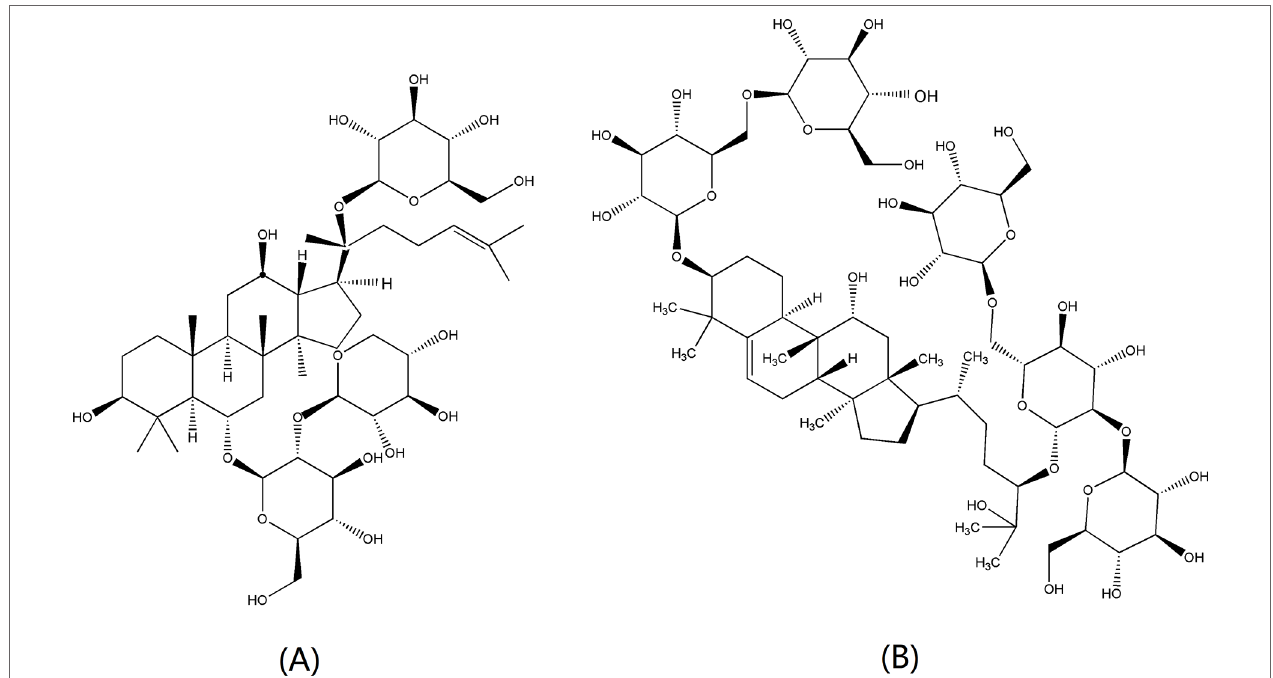
FIGURE 1 | Chemical structures of (A) notoginsenoside R1 (IS) and (B) mogroside